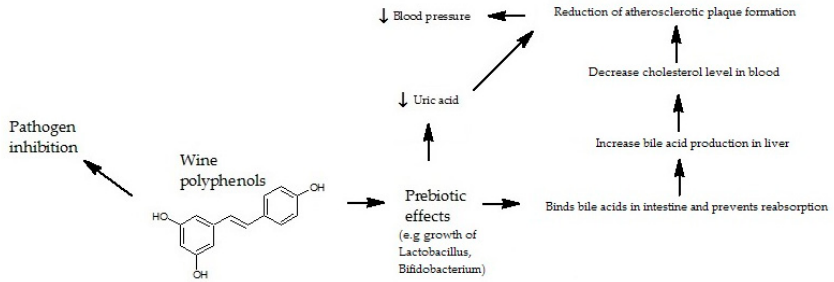
Figure 3. Interaction between wine polyphenols and gut microbiota.